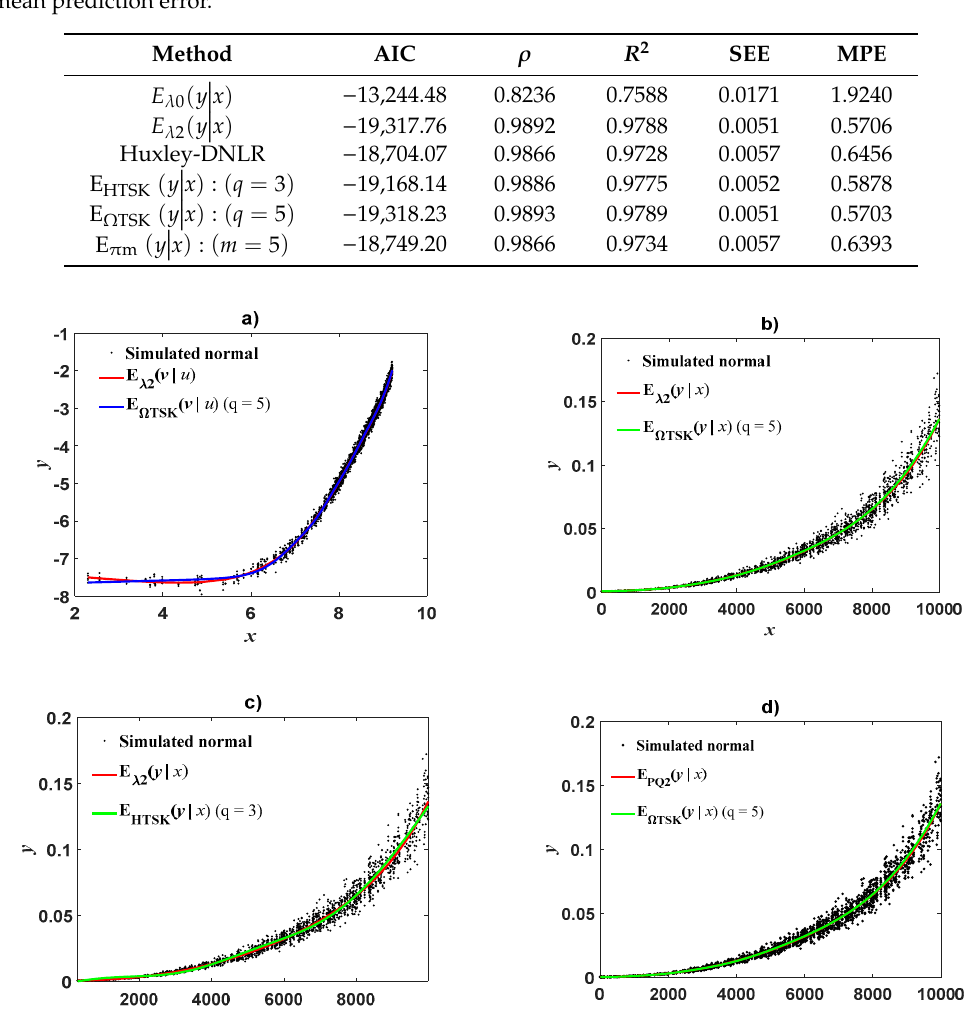
(cid:12) (cid:12) (cid:12) x ) is for back transformed ( x ) TSK